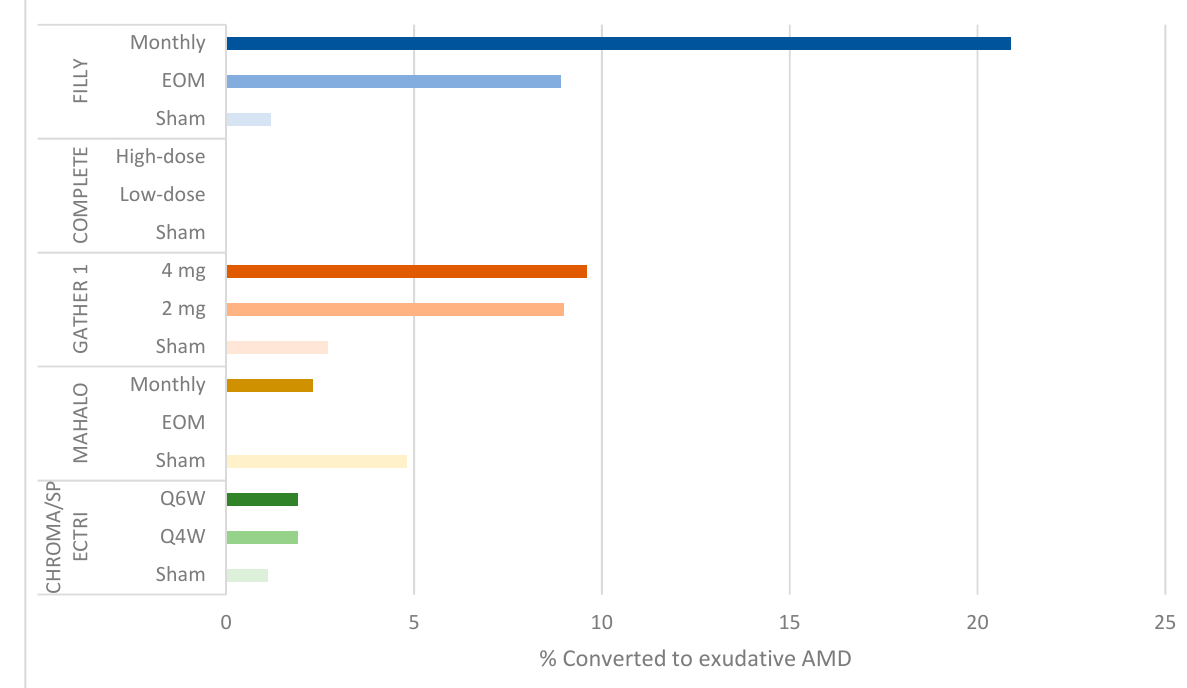
elevated intraocular pressure) compared to 2.5% in the EOM group and 1.2% in the sham groups (Figure 2). Additionally, 20.9% (95% CI: 12.9–31%) of participants in the monthly group converted to eAMD, compared to 8.9% (95% CI: 3.6–17.4%) in the EOM group and 1.2% (95% CI: 0–6.7%) in the sham groups (Figure 3). While a post hoc analysis of FILLY data outlined some risk factors for conversion to eAMD, including baseline eAMD in the contralateral eye and a double-layer sign on ocular coherence tomography (OCT) in the study eye, there was a persistent dose-related association between complement inhibition Figure 2. Bar graph showing percentage of discontinuation or withdrawal by study group. and the development of eAMD, regardless of the presence of these risk factors [13]. Additionally, the rates of serious ocular adverse events and conversion to eAMD re- sulting in withdrawal or discontinuation were dose related: 4.7% of subjects in the monthly group developed serious ocular adverse events (including endophthlamitis and